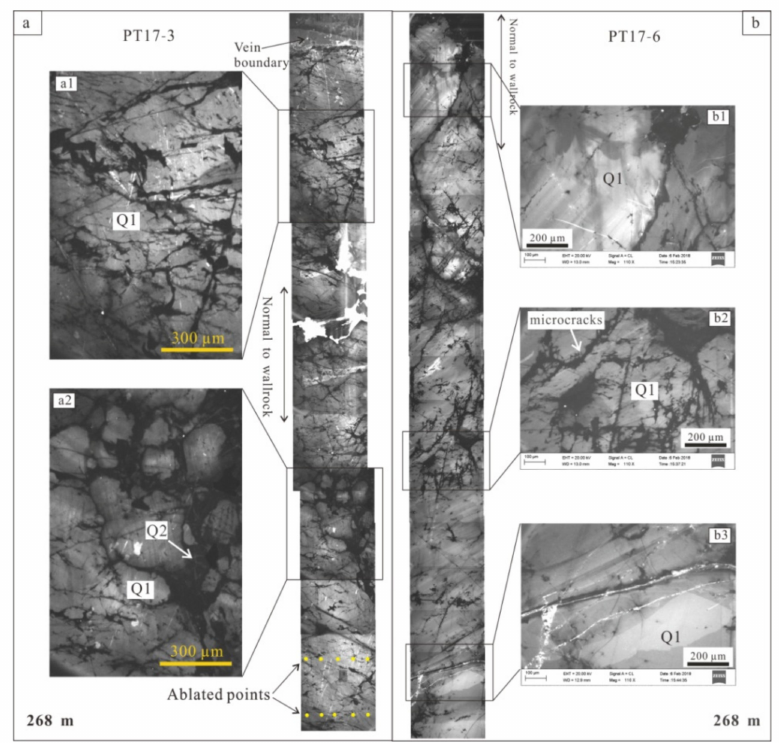
Figure 9. Composite SEM–CL panchromatic images of the samples PT17-3 ( a ) and PT17-6 ( b ). The early CL–bright quartz (Q1) accounts for a much larger proportion of the images than another generation of CL–dark quartz